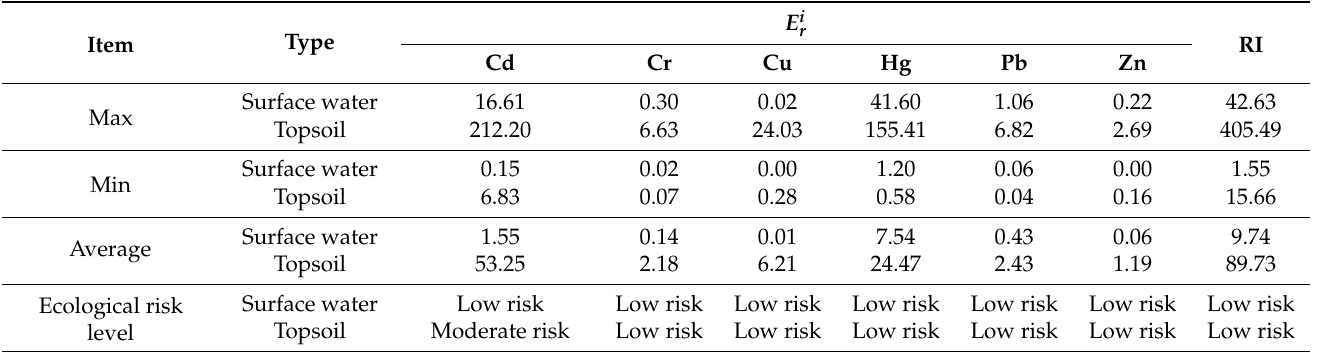
Table 8. Ecological risk index ( E i r ) and potential ecological risk index (RI) for six heavy metals in topsoil and surface water of study